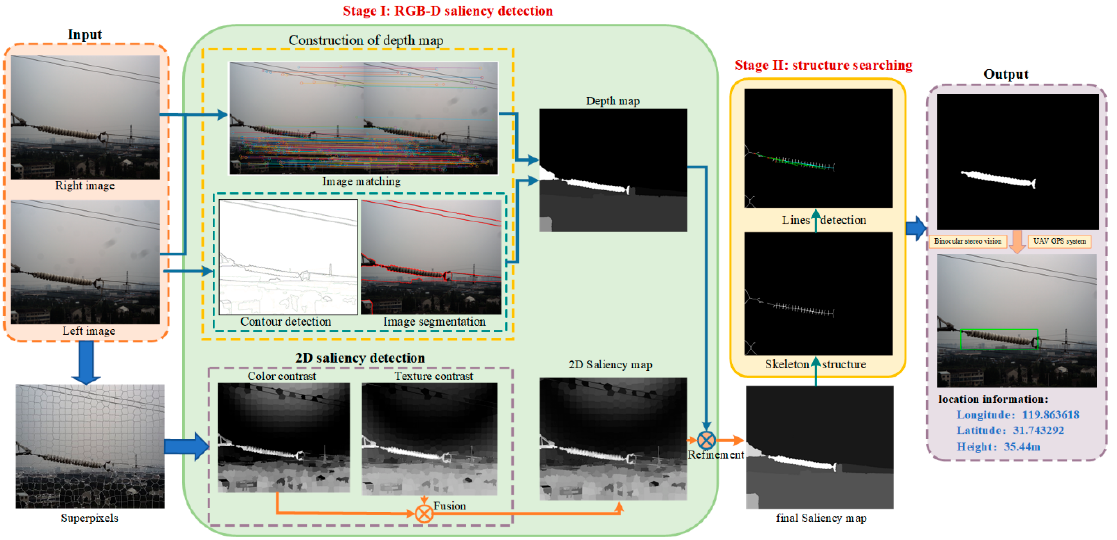
Figure 3. The sketch map of the proposed method.